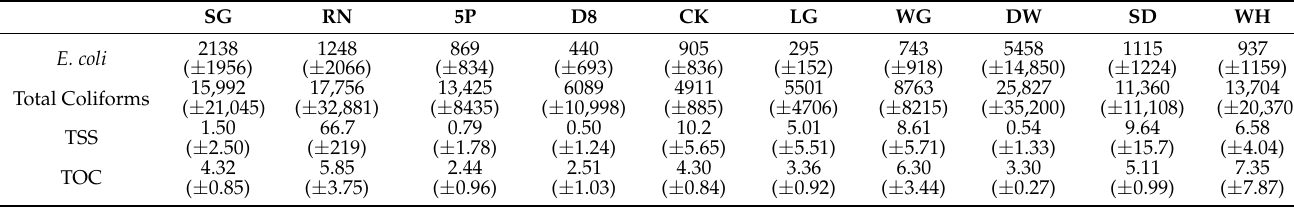
Table 6. Mean E. coli , total coliforms, TSS, and TOC concentration values for each site along with their standard deviation. E. coli and total coliforms are reported in most probable number per 100 mL sample (MPN/100 mL), and TSS and TOC are reported in